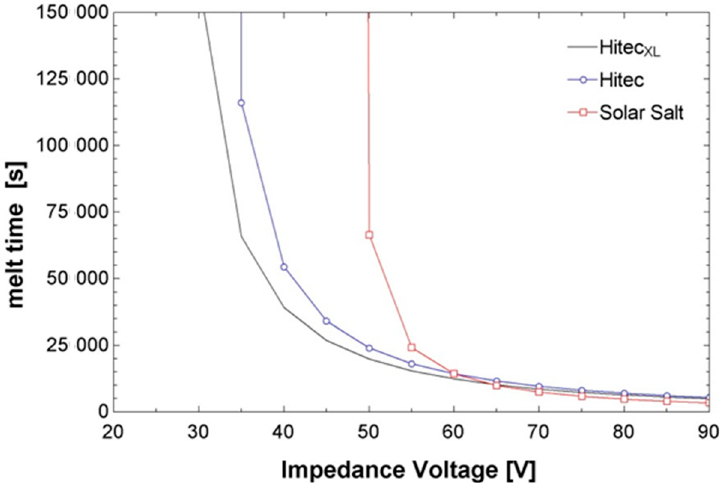
Figure 12. Melting time as a function of the total solar collector assembly impedance voltage with the following system configurations: Solar radiation = 0 W / m 2 , wind speed = 5 m / s, glazing intact, vacuum intact.